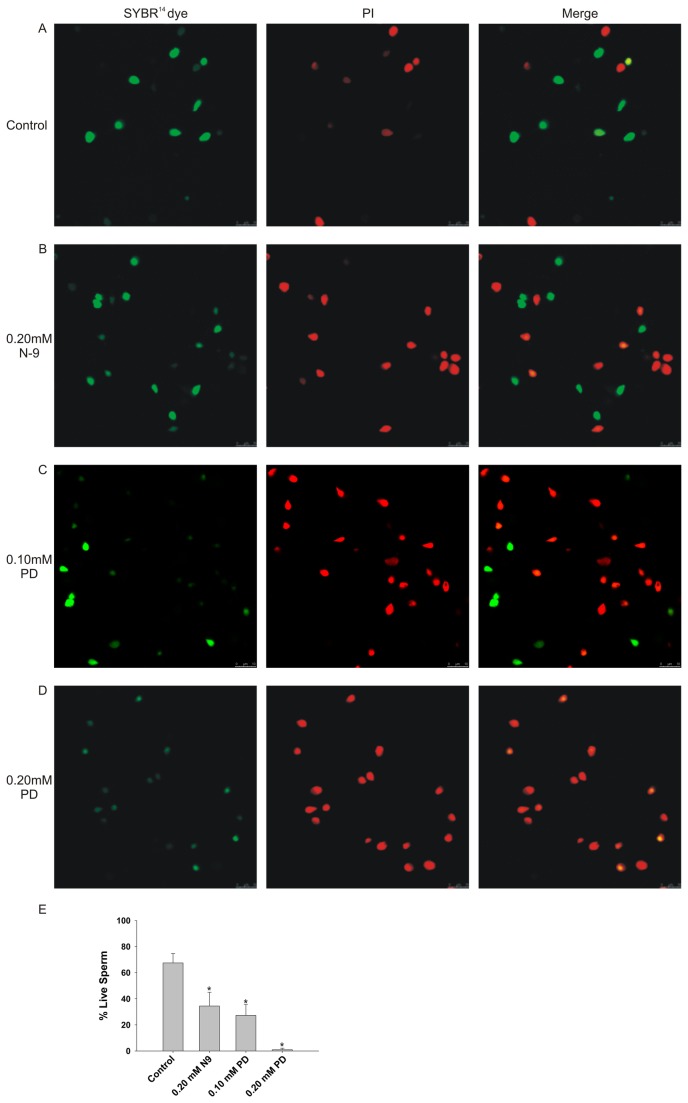
The sperm viability, as assessed by a fluorescent staining method.Live sperm cells fluoresced green (SYBR-14 dye), and dead sperm cells fluoresced red (PI) (1600×). (A) Control live sperm appeared green, confirming the utility of the assay. The spermatozoa treated with 0.20 mM N-9 (B) and 0.20 mM PD (C) both exhibited PI staining (red). (D) The sperm count showed that 0.20 mM PD killed almost all of the sperm, while 0.20 mM of N-9 only killed 65.5% of the spermatozoa. Each bar represents the mean ± SEM of six sets of observations; *: Significantly different from the control, p<0.05.